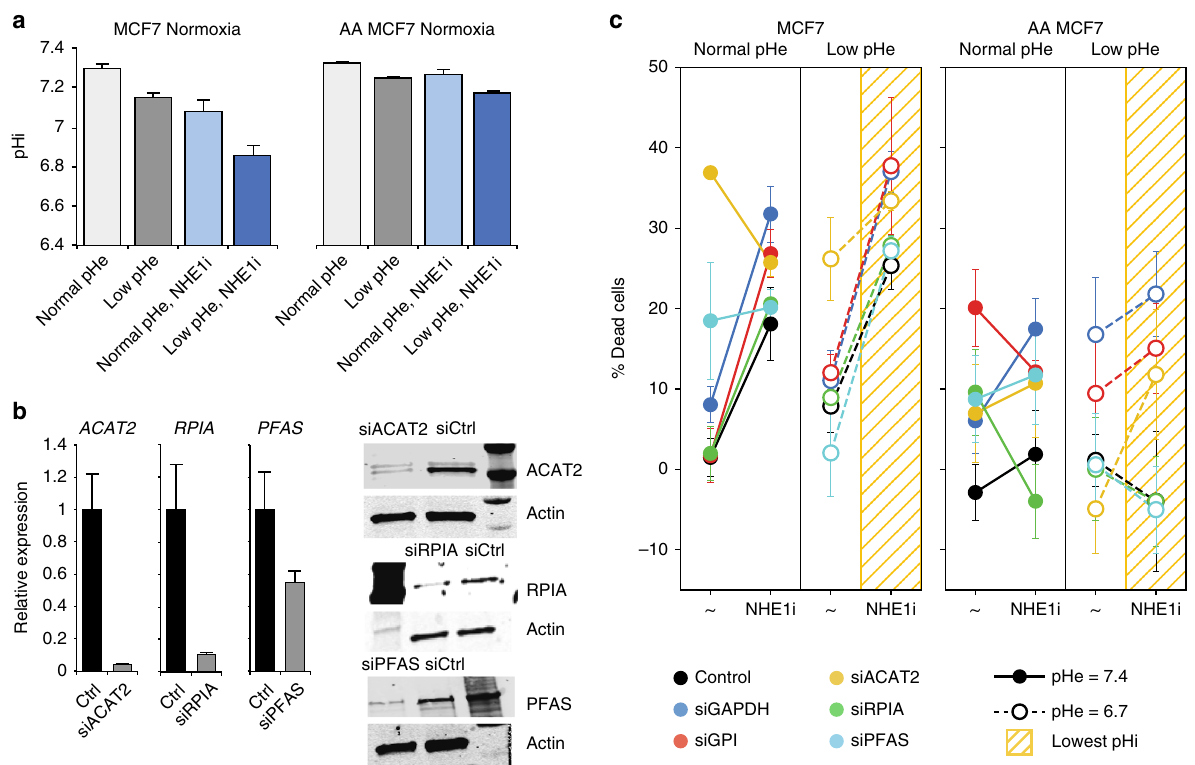
Fig. 4 Validation of systems analyses in predicting pHi-sensitive metabolic vulnerabilities. a pHi measurements of naïve and acid-adapted (AA) breast cancer MCF7 cells, under normoxia and following the inhibition of NHE1 , by cariporide treatment. For pHi measurments at least 30 cells were analyzed. b Ef fi ciency of knockdown of indicated targets at the mRNA and protein levels, following reverse transfection of MCF7 cells with the indicated siRNAs. qPCR was repeated at least three times with three replicates. c The effect of gene inhibition in normal and low extracellular pH (pHe) shown for naïve and AA MCF7 breast cancer cells. Similar color code to Fig. 3 is applied. At low pHe where the lowest pHi was obtained there is a large reduction in the viability of cells. In AA cells, only the selective and pH-speci fi c targets ( GAPDH , GPI , and ACAT2 ) achieve ampli fi ed anti-proliferative effects following NHE1 inhibition, despite the smaller reduction in the pHi of these cells. PFAS , a selective but not pH-speci fi c target, is similar to control cells following NHE1 inhibition. Knockdown of RPIA had a weak effect in naïve cells and no/opposite effects in AA cells. The viability assay was done three times with four replicates each time. The bars depict the mean and the error bars depict the standard deviation of the